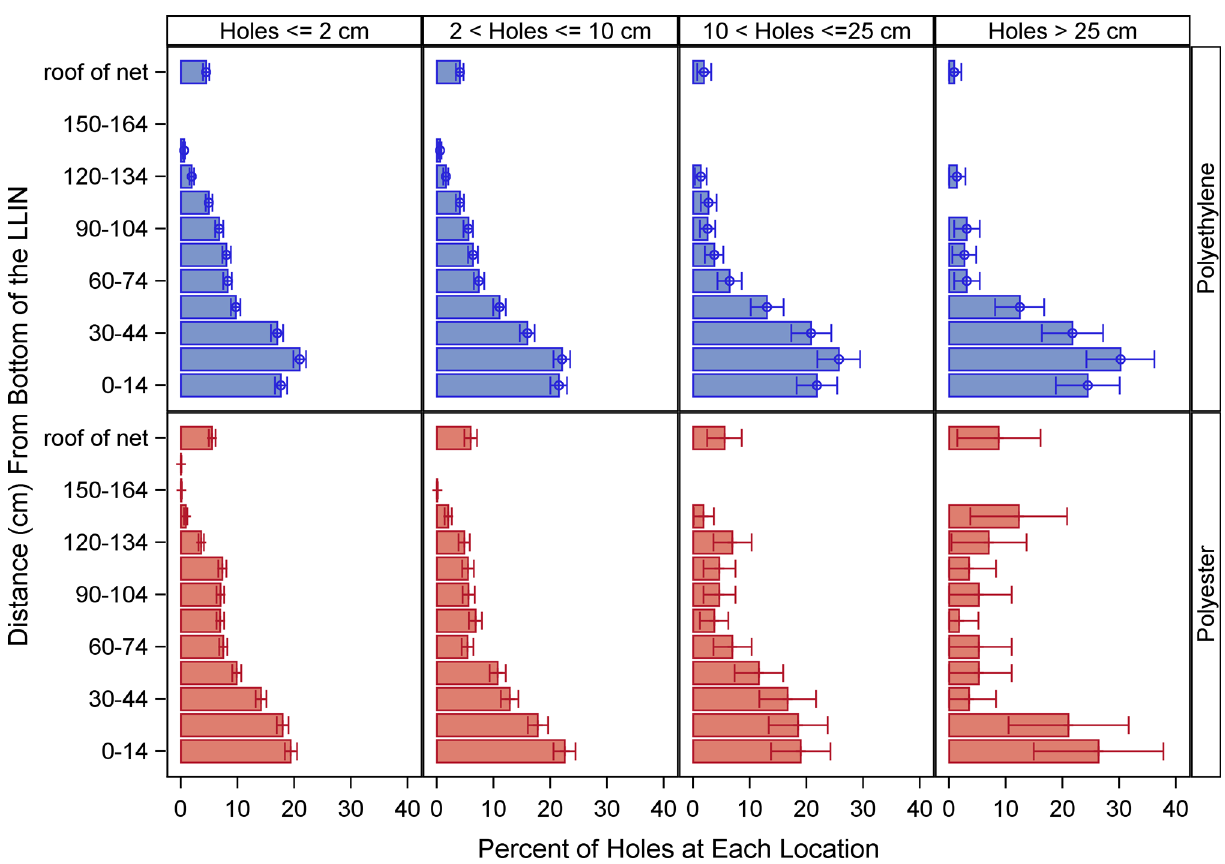
Fig 5. Percent of holes of each WHOPES size category located at varying distances from the bottom of the net by type. Error bars represent 95% confidence limits. Polyester nets: 100 denier, traverse [3.5.50], Polyethylene nets: 150 denier, tulle